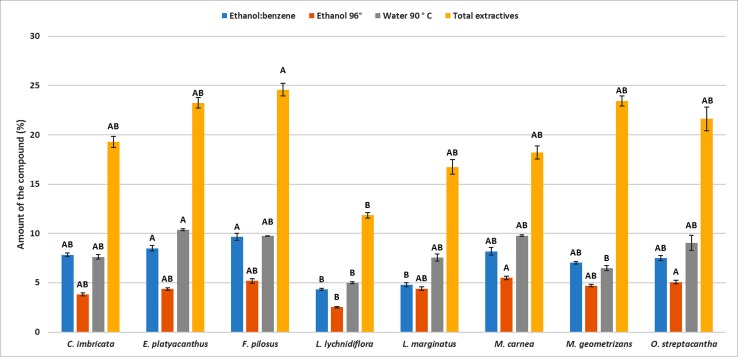
Mean of the percentages for each type of extractive in eight Cactaceae species. Different letters indicate significant differences between means based on pairwise multiple comparison Dunn’s test (p ≤ 0.05). Bars represent standard deviation.